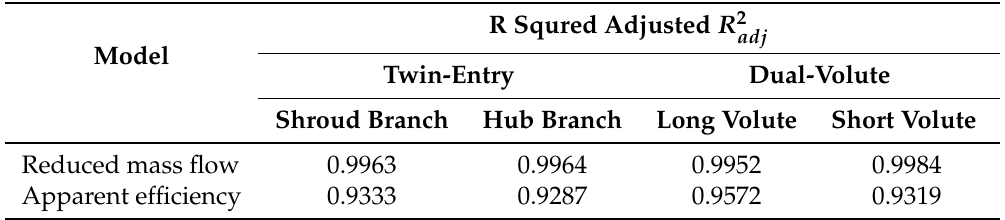
Table 7. Values of adjusted coefficient determination for both T#1TE and